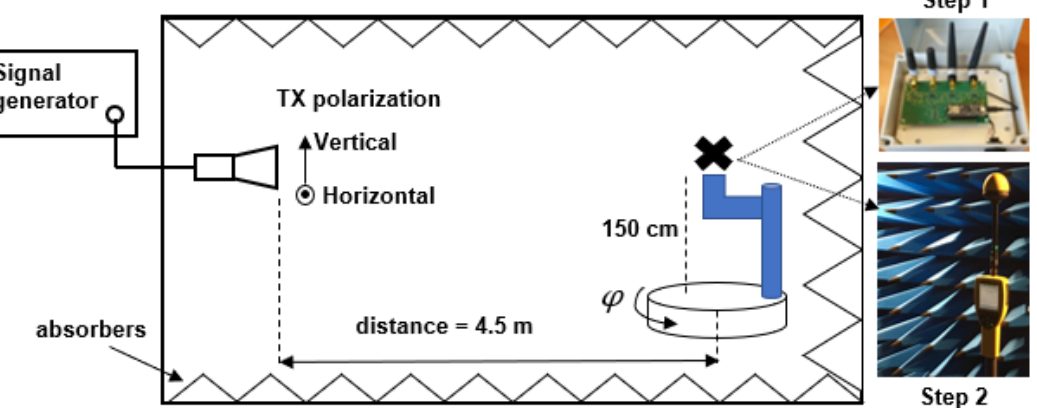
Figure A1. The free-space calibration measurement setup in the anechoic chamber. In Step 1, an RF-EMF sensor node is held by a Styrofoam arm mounted on a rotational platform (the location of the node is indicated by ‘X’), and the received powers were registered as a function of two polarizations of the transmitter antenna (TX) and the rotation ( φ ) over 360 degrees. In Step 2, a Narda NBM-550 broadband meter with EF 0391 triaxial field probe was placed at the same location and height of the RF-EMF sensor, and the incident power densities were measured.